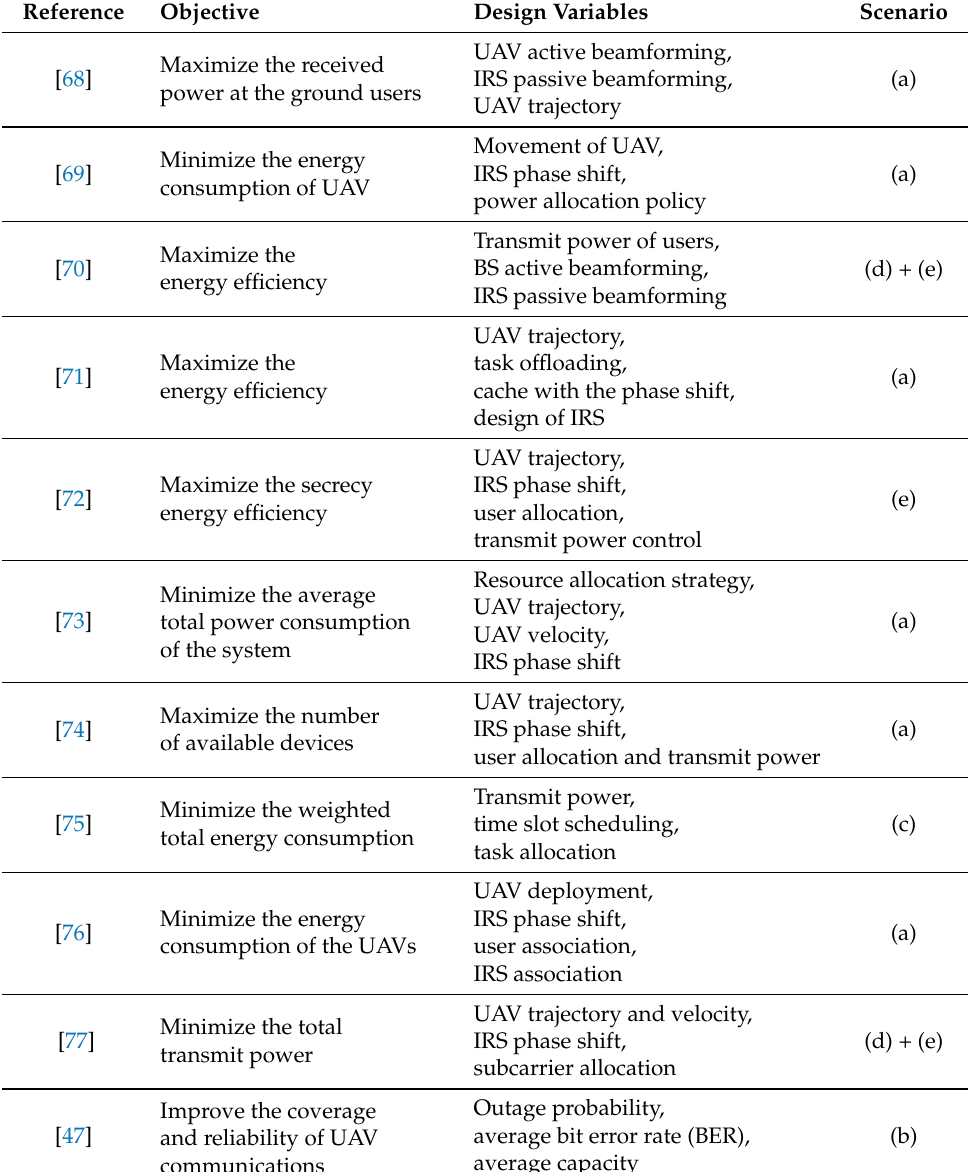
Table 2. Summary of previous works relevant to improvement of energy